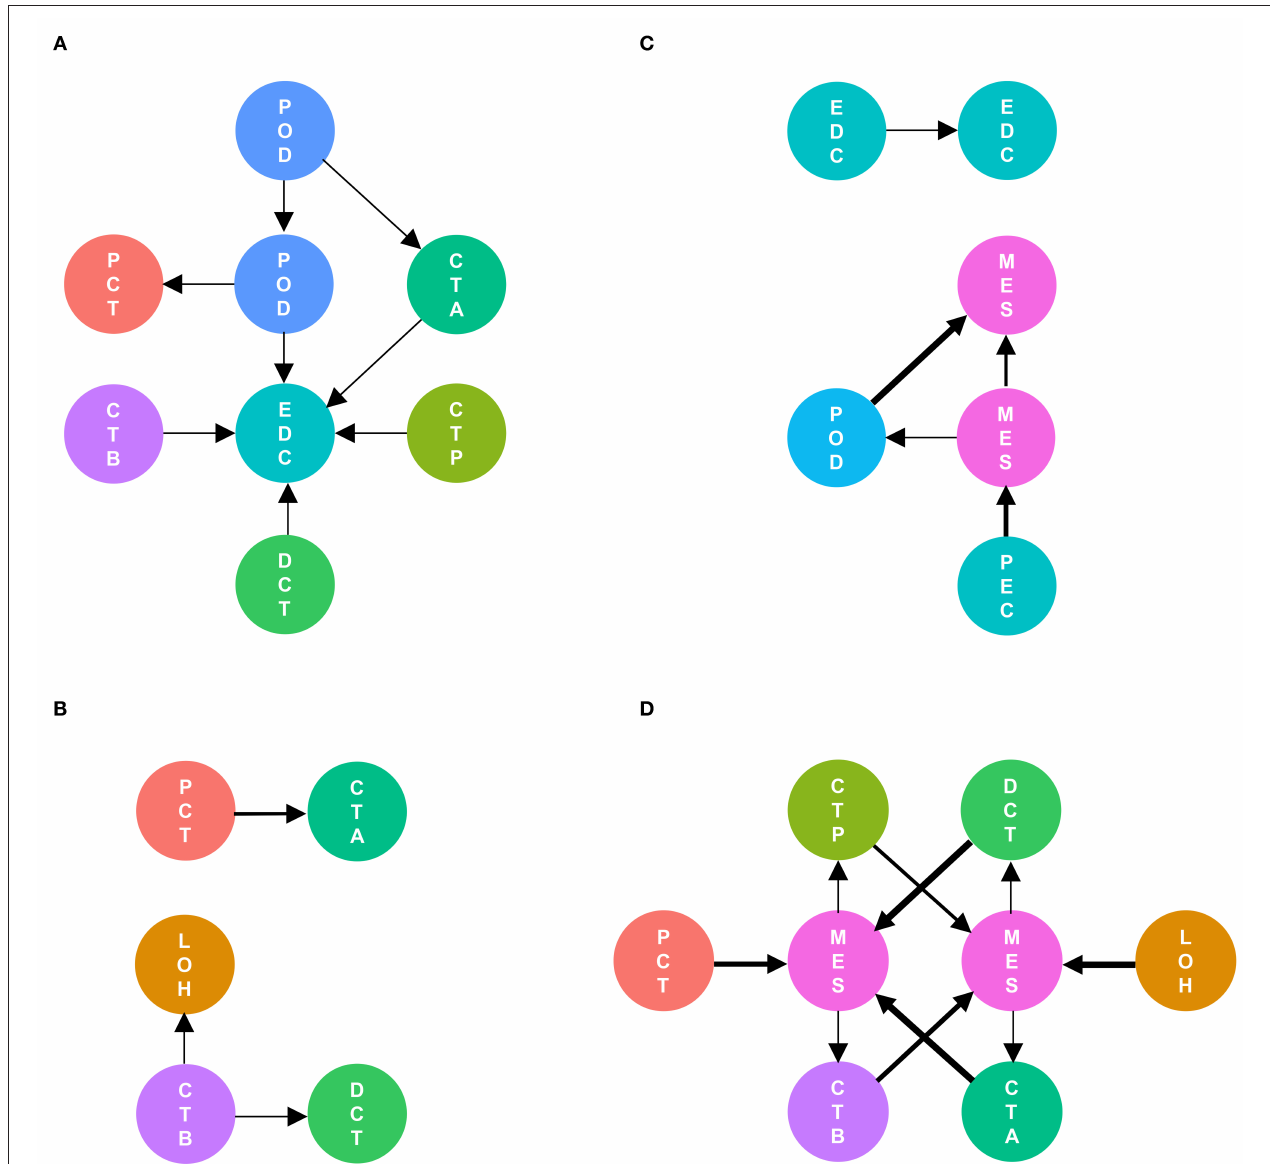
FIGURE 6 | Different types of cells are activated in cell communication in DKD. The involved cell types are summarized and the thickness of the arrow represents the number of interactions. We divided the cell cross-talk into four groups: same cell cross-talk between nondiabetic and diabetic kidneys (A) , cell cross-talk in tubules (B) , cell cross-talk in glomeruli (C) , and glomerulotubular cell cross-talk (D)